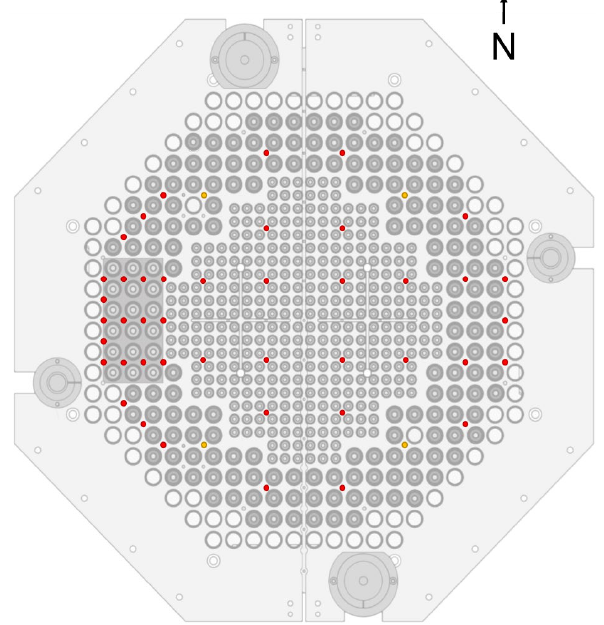
Fig. 2. Horizontal cut of CROCUS representing one of the three main layers of the 3D mapping system. Red dots represent the position of interest to install neutron detectors, while in yellow are indicated the positions where two supplementary intermediate layers of detectors are